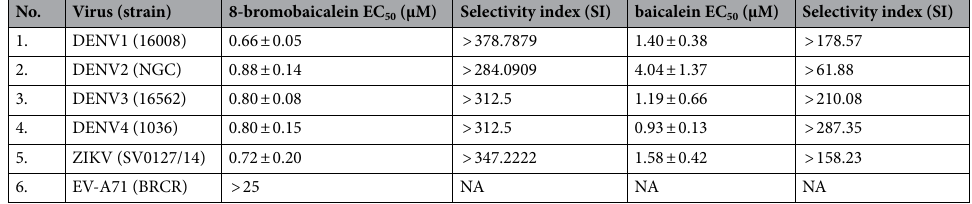
Table 2. Efficacy of an 8-bromobaicalein to dengue, zika and enteroviruses in LLC/MK2 cells. Errors were calculated from three independent experiments. NA (not applicable) refers to the experiments not performed. No statistical significance was found between the results of both compounds (unpaired t-test).